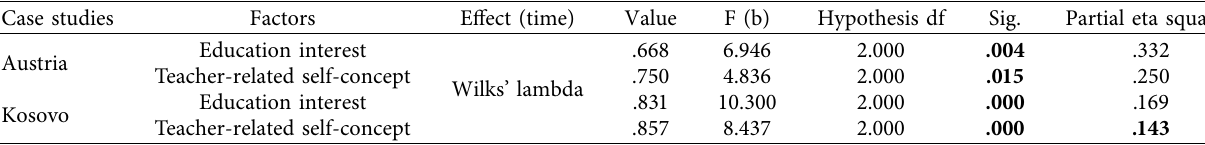
Table 6: Multivariate tests within-subject design (time).